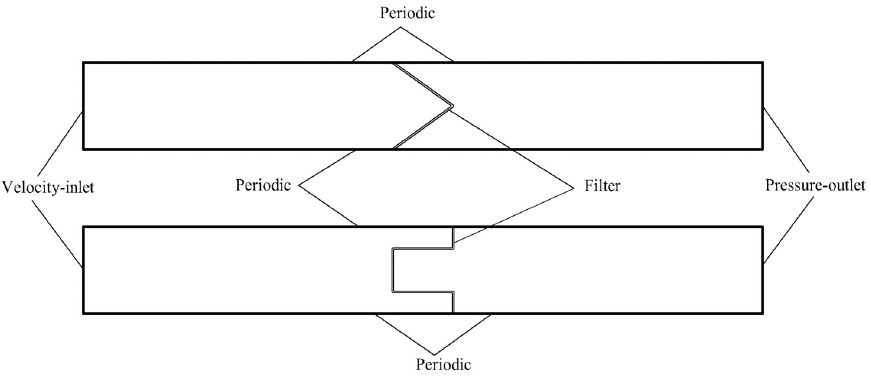
Fig 6. Numerical simulation computational